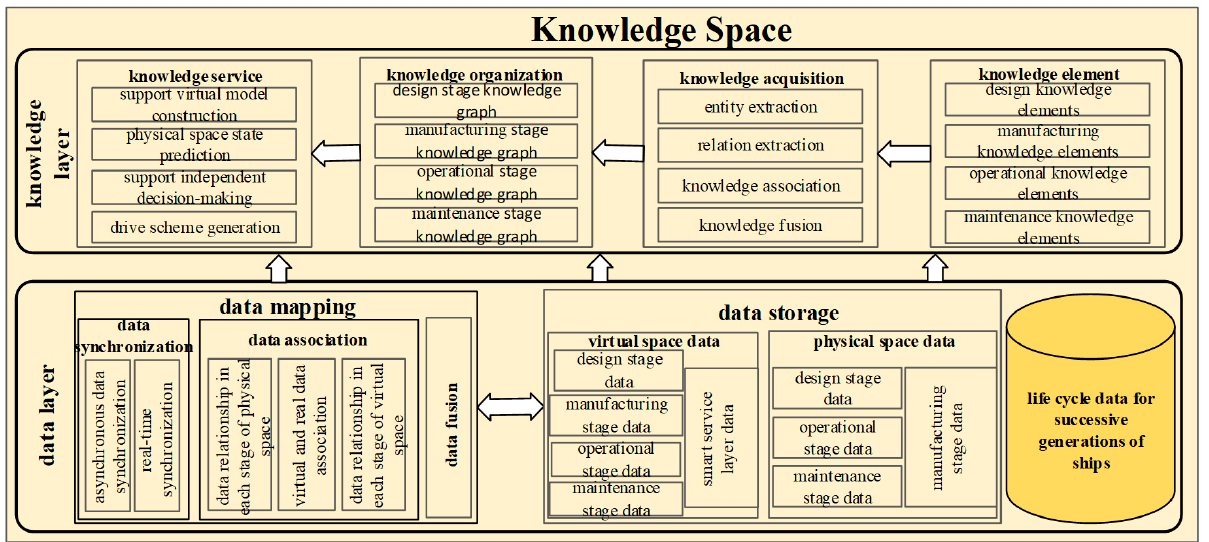
Figure 4. The structure of the knowledge